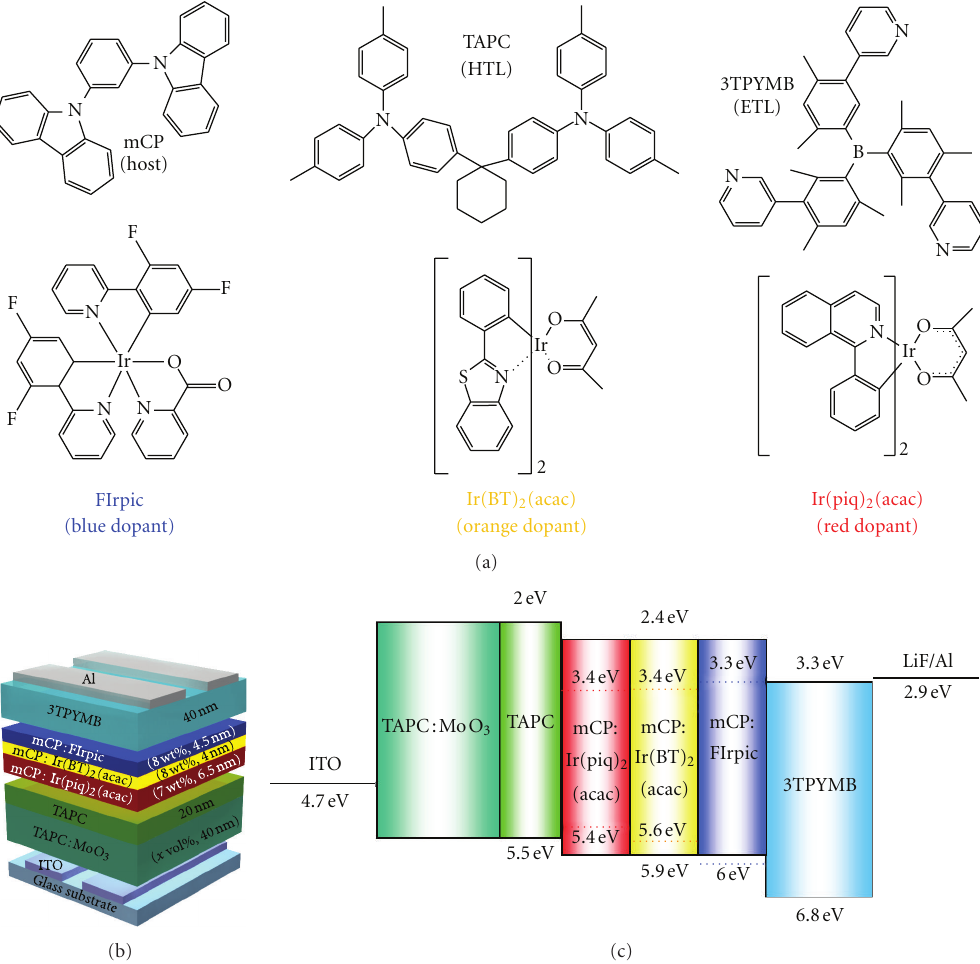
Figure 3: (a) Chemical structure of the organic materials, (b) device structure, and (c) schematic energy level diagram of